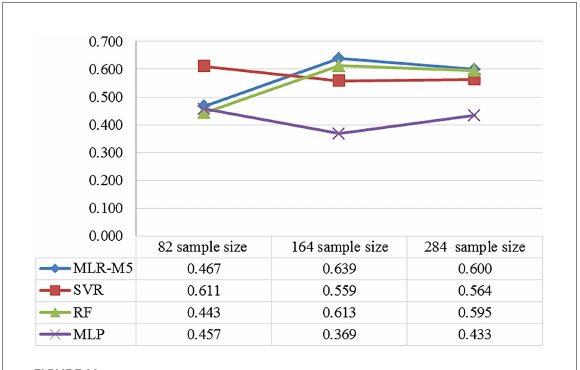
FIGURE 11 The comparison of the regression prediction results of the different sample